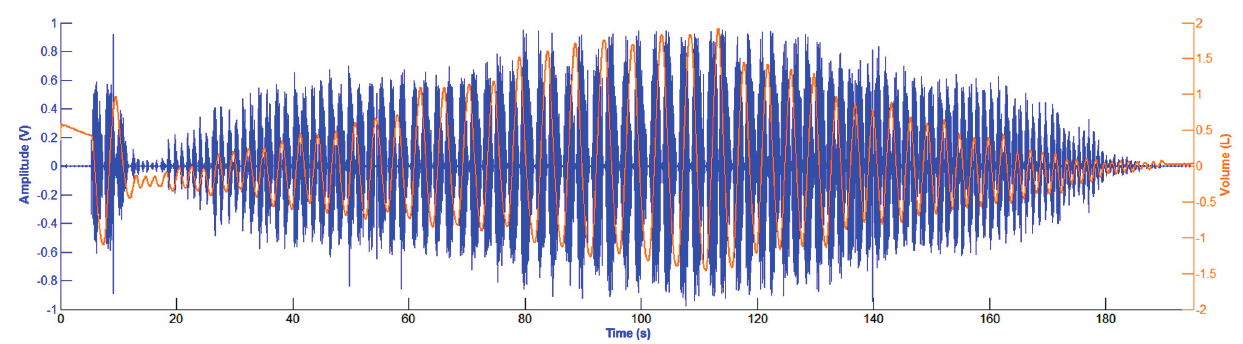
Figure 3. Filtered, detrended and aligned tracheal sounds and volume signal during the respiratory maneuver. Tracheal sound (in volts) is represented in blue, while volume signal (in liters) is in